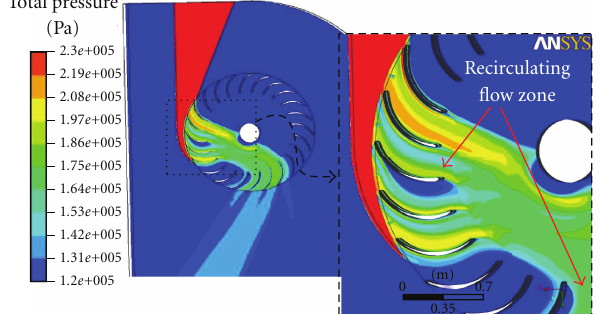
Figure 14: Total pressure contour at midspan of domain nozzle and runner casing for runner speed 400 rpm.